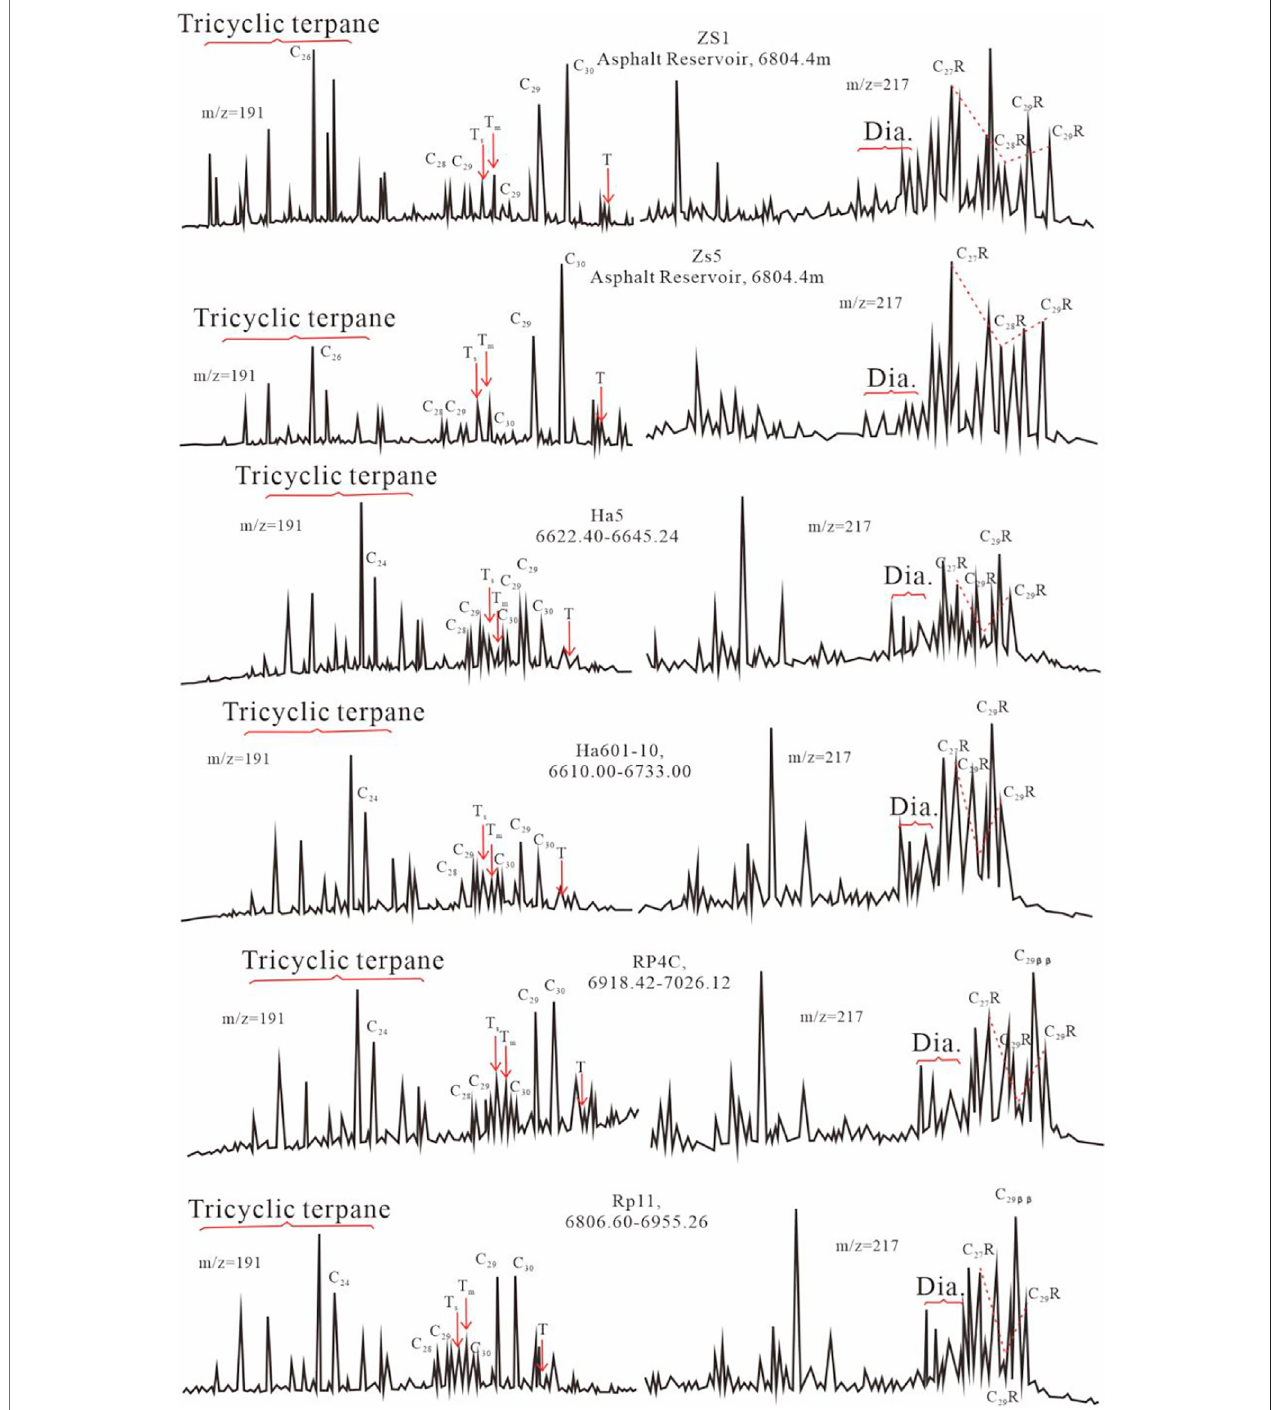
FIGURE 8 | Chromatograms of terpanes and steranes in Ordovician crude oils from Halahatang and its surrounding areas.